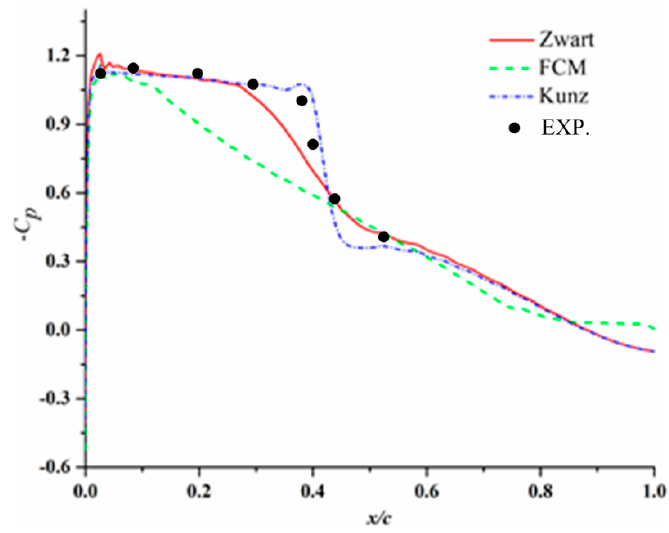
Figure 5. Suction side wall pressure distributions calculated by using three different cavitation models ( σ = 1.075, α = 60°).